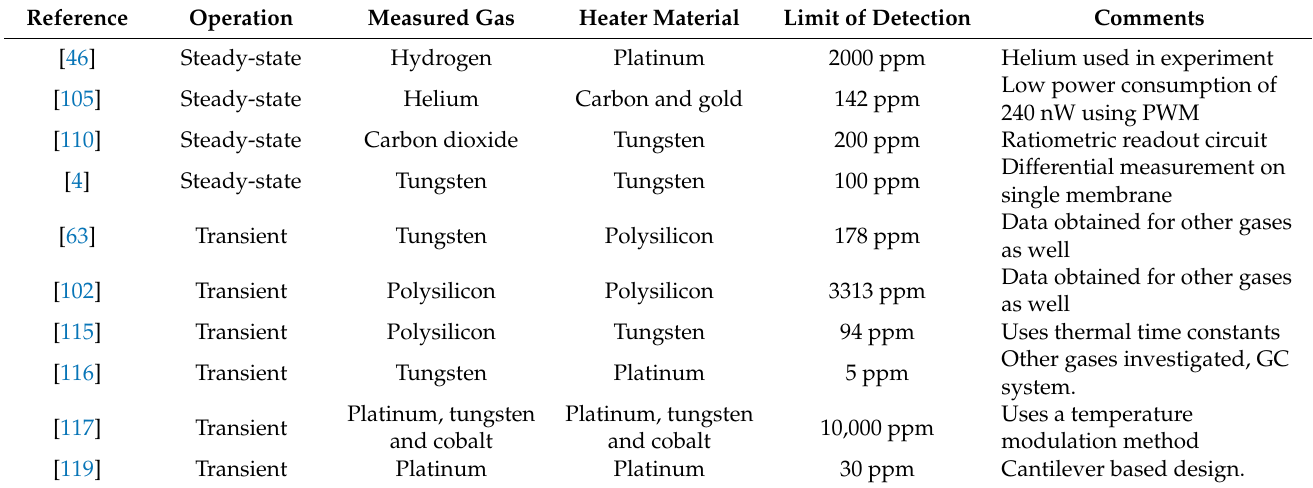
Table 5. A comparative table between some of the recent works in thermal conductivity gas